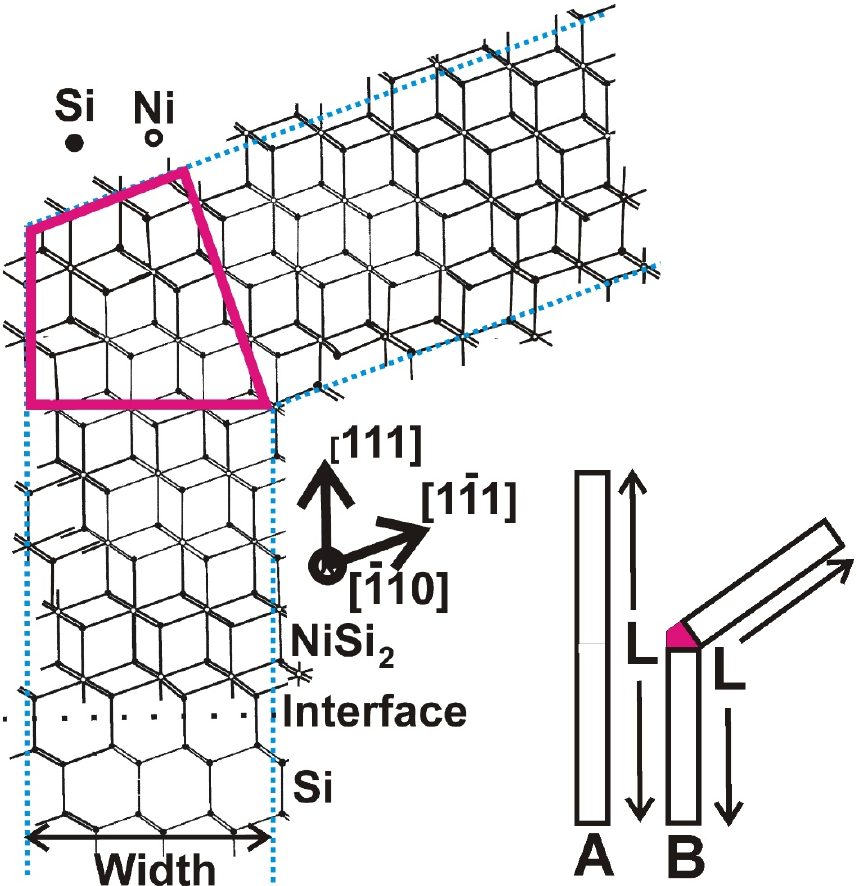
Figure 9. Schematic representation of a fast [111] whisker denoted by the letter A which grows linearly having a length L. Compare this whisker with the whisker B having the same total length L. During the growth, the whisker B switches to the equivalent [111] direction. Although the two whiskers have the same length, an extra part denoted by red is required for the switching, including the formation of extra dangling bonds. This is also shown schematically in atomic scale in the section (110).